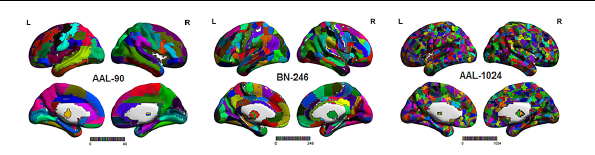
FIGURE 1 | The three atlases including AAL-90 atlas, BN-246 atlas, and AAL-1024 atlas.